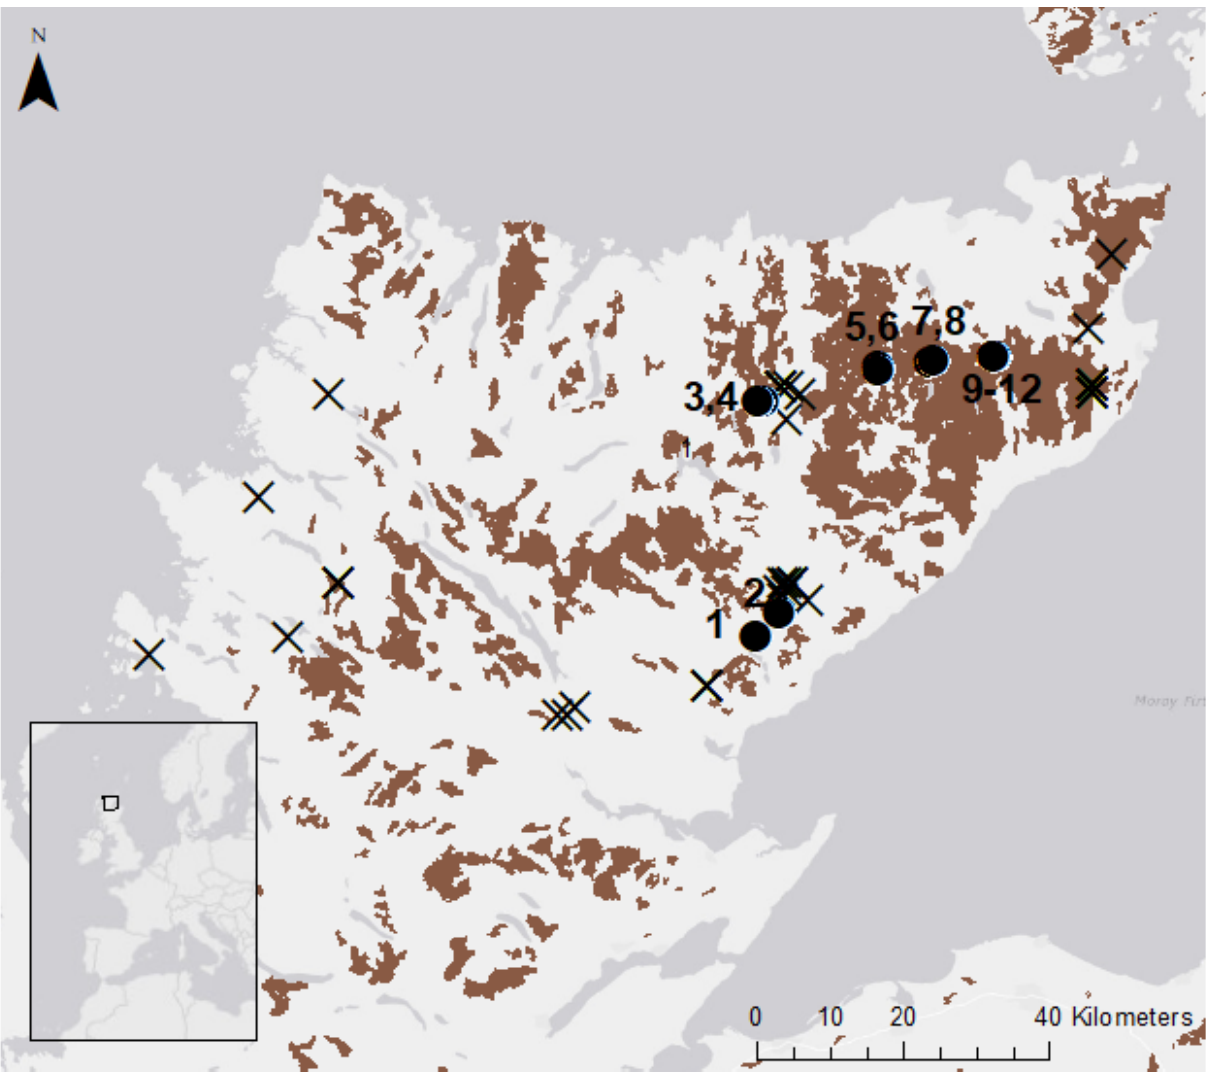
Figure 1. Sites for which carbon accumulation has been inferred (crosses) and measured (circles). Brown shading indicates areas of deep peat from the James Hutton Institute peat map (Scottish Government 2018). Numbers indicate the measured sites: 1) GB1, 2) GB2, 3) CRSLF, 4) CRSLO, 5) CATO, 6)